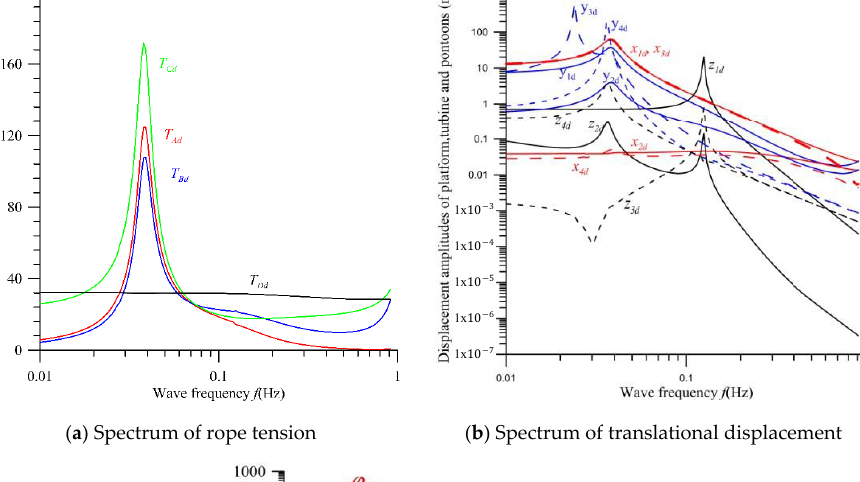
Figure 13. Spectrum of rope tension ( L C = L D = 60 m β P = 0.1, β T = 0).